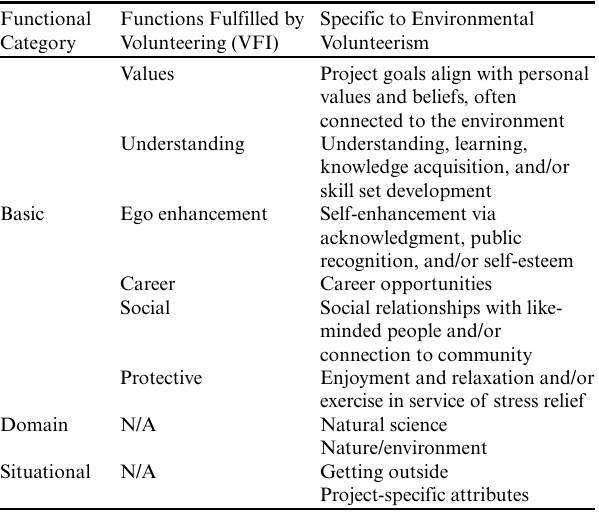
Table 1 . Structural functionalism as defined by the basic functions of volunteering outlined by Katz (1960) and adapted by Clary and Snyder (1999) in their Volunteer Functions Inventory (VFI) and ensuing environmental volunteerism studies (see text). The latter studies also define the domain-specific and situation- specific functions we have